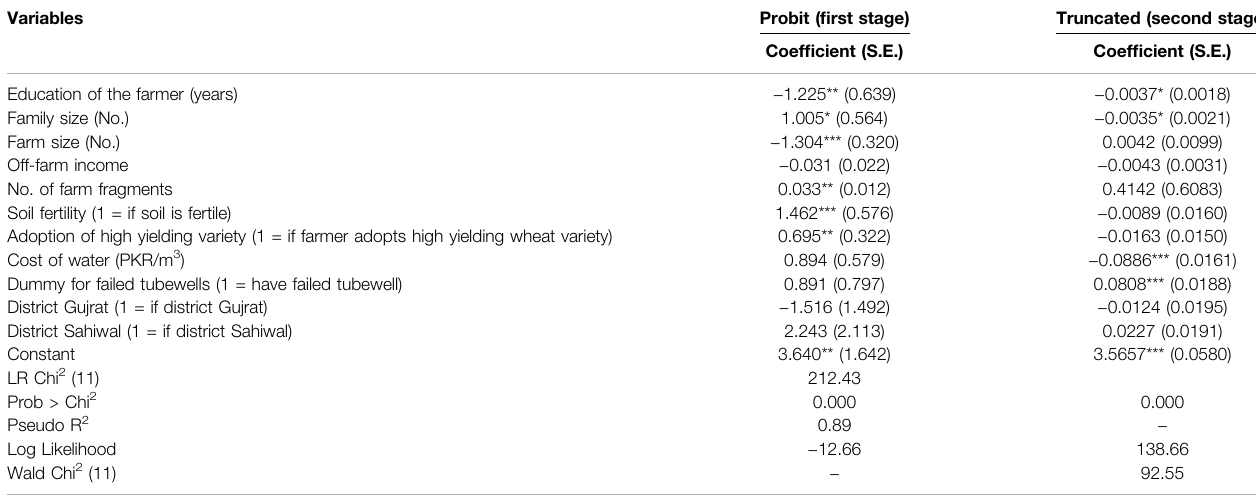
TABLE 3 | Factors affecting water buying and level of water